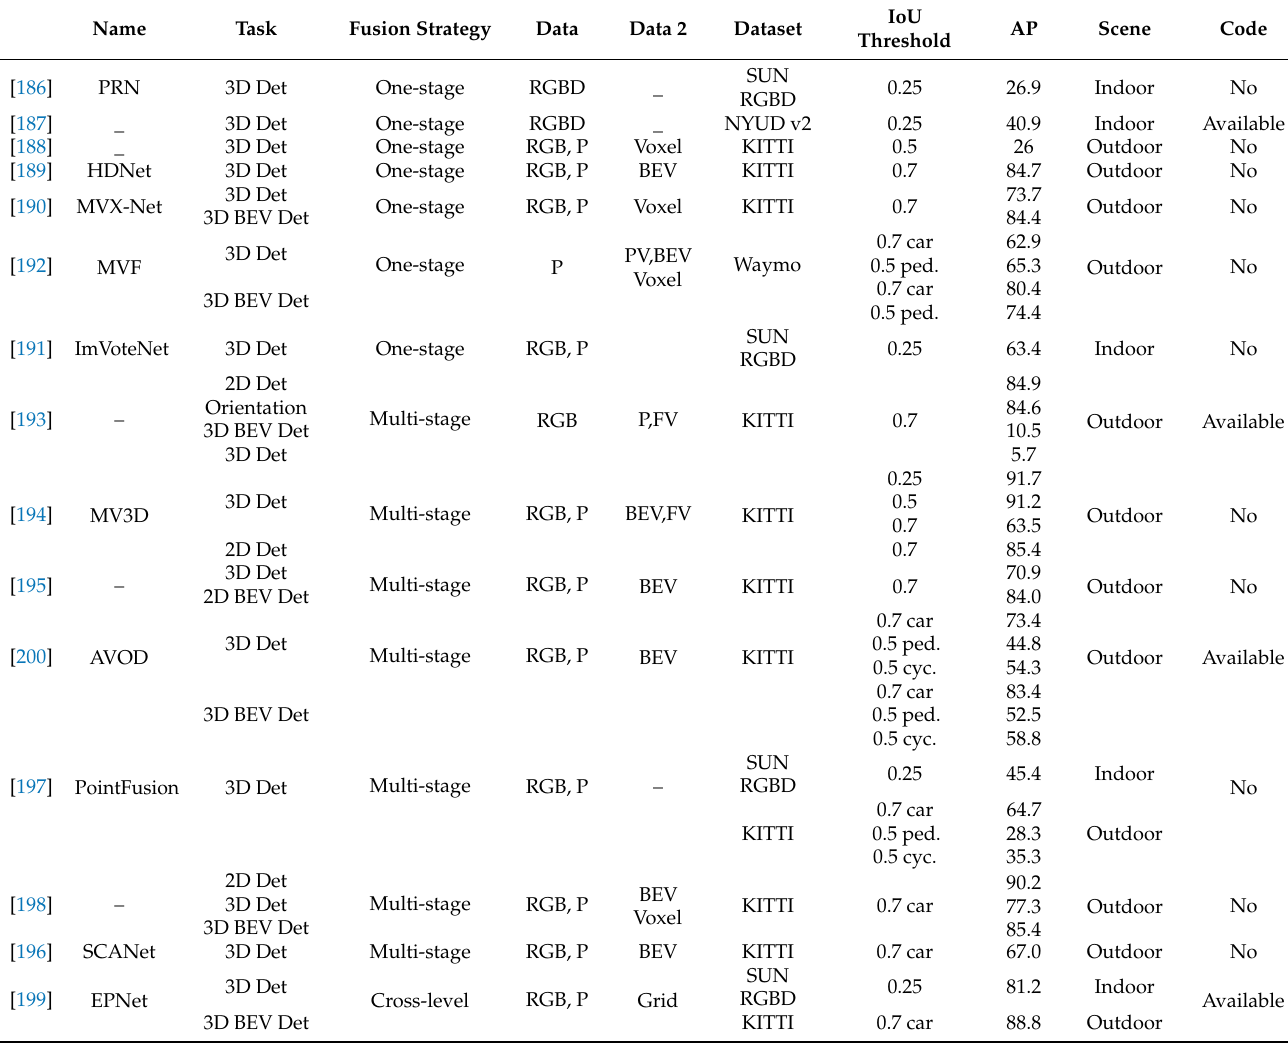
Figure 9. The representative detection methods using cross-level feature-based fusion strategy. Table 10. Comparative summary of detection methods using feature-based fusion strategy (P: point cloud; Data 2: intermediate